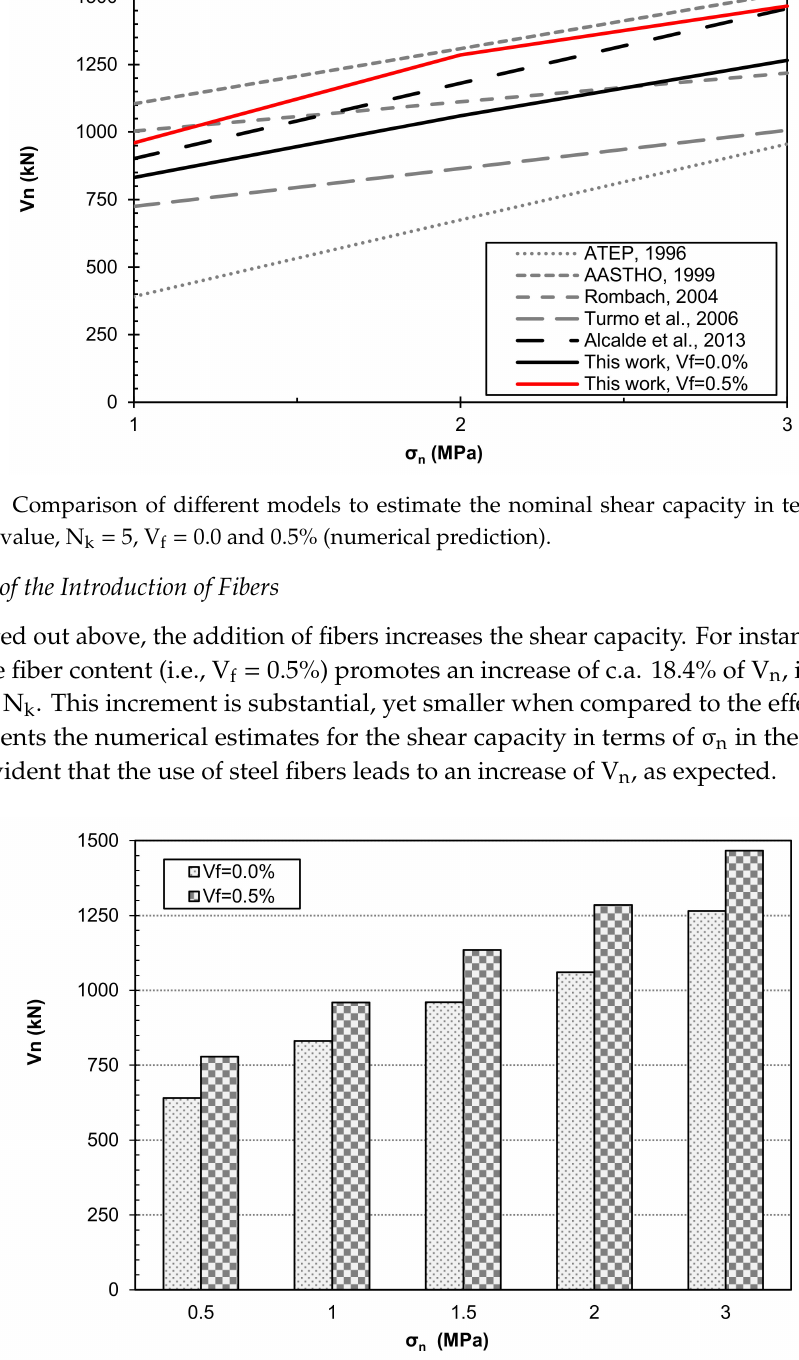
Figure 7. E ff ect of the use of fibers on the nominal shear capacity in terms of the prestress, N k =